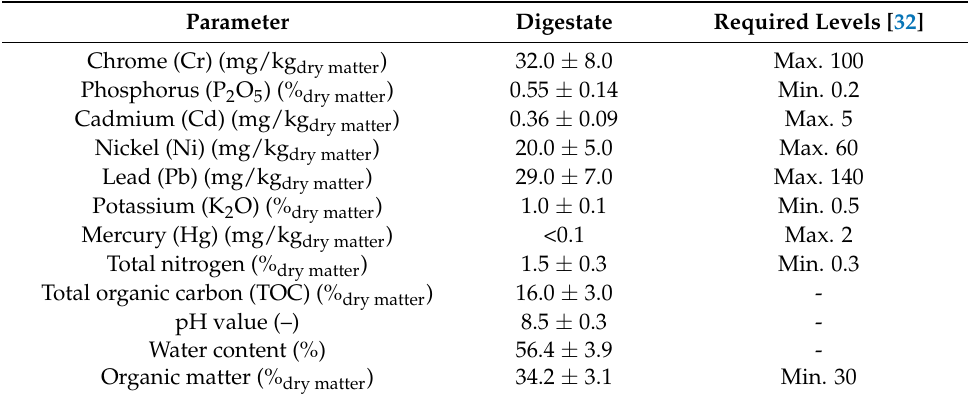
Table 3. A characterization of the digestate derived from